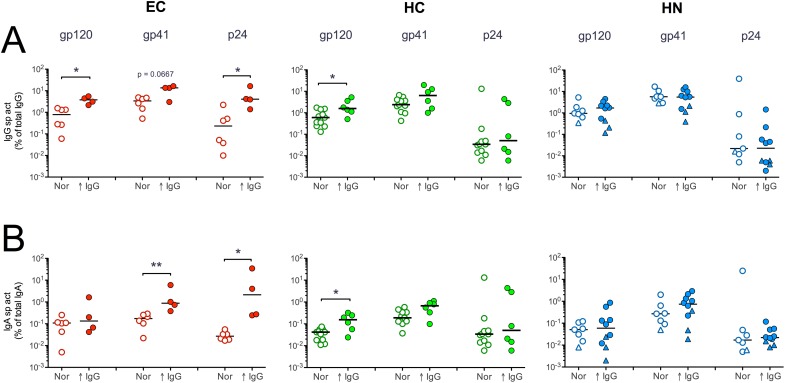
HIV-specific IgG and IgA responses in individuals with normal or elevated total IgG concentration.The gp120, gp41 and p24 sp. act. of (A) IgG and (B) IgA antibodies measured in subjects with normal levels of total IgG (Nor; open circles) is shown in comparison to those with IgG hypergammaglobulinemia (↑ IgG; closed circles). The triangles in the HN graphs represent the 4 subjects with IgA hypergammaglobulinemia. Bars are medians. *p < 0.05 or **p < 0.01 by Mann-Whitney rank sum test.